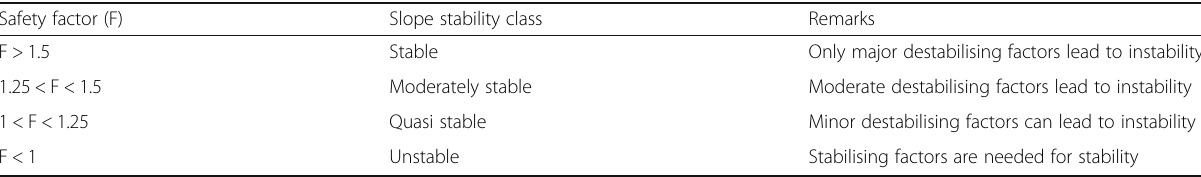
Table 3 Slope stability